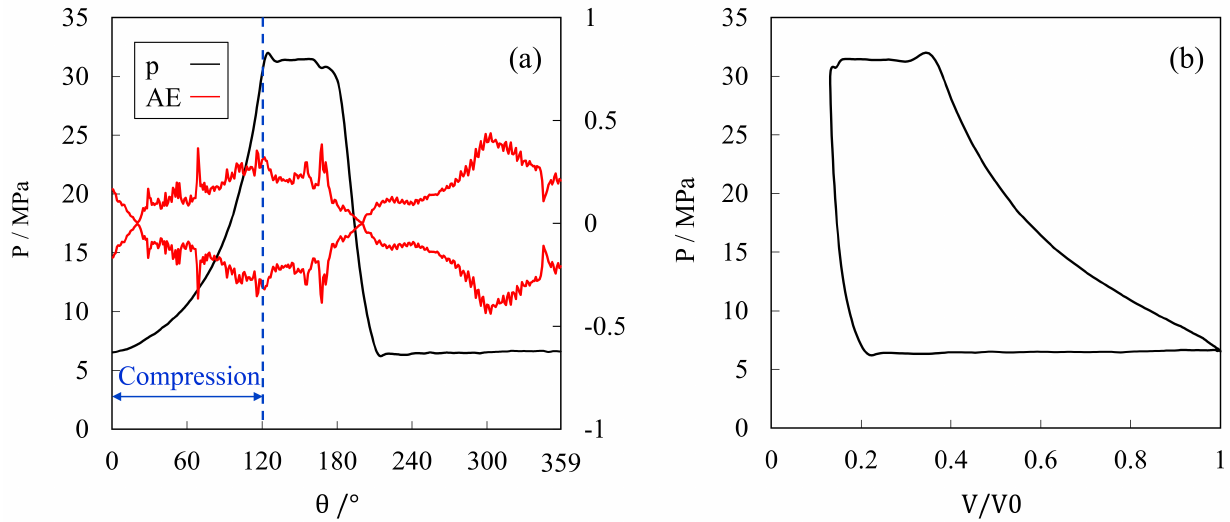
Figure 21. p − θ diagram integrated with AE signal ( a ) and p − V diagram ( b ) of a leakage valve in the hydraulically driven piston compressor.